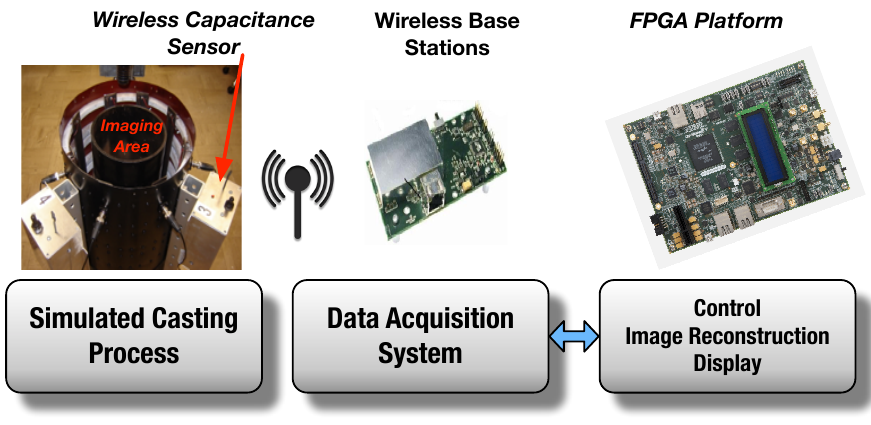
Figure 2. Wireless electrical capacitance tomography